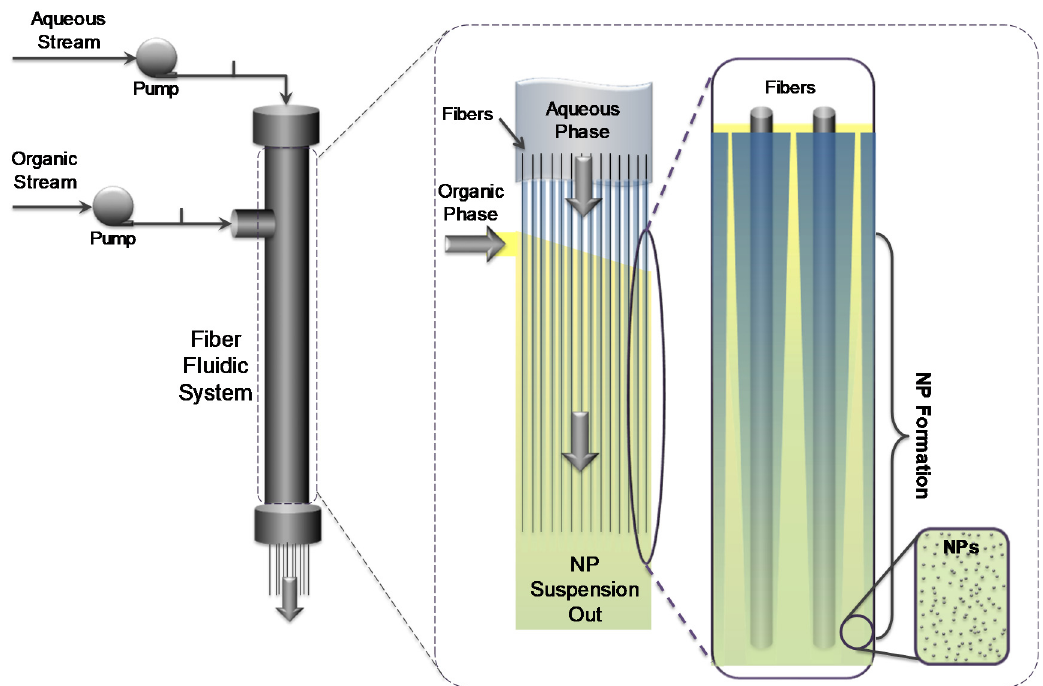
Figure 2. Schematic of an inside cross section of the reactor.